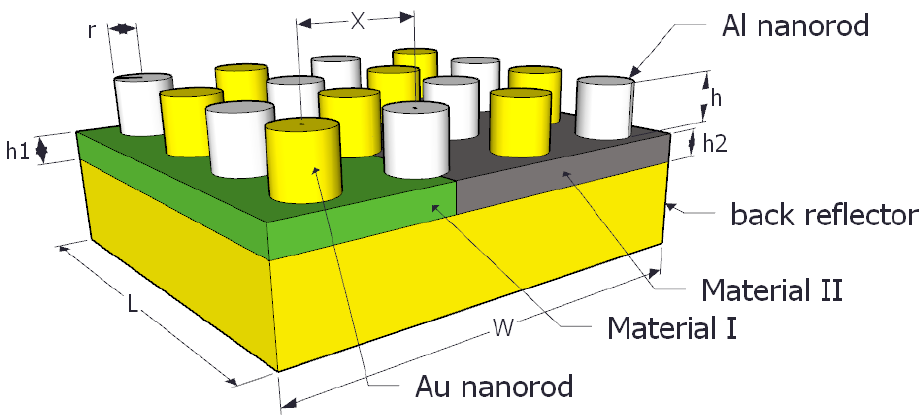
Figure 7. MMA side-by-side multi-dielectric layers structure with alternating nanorods distribution.